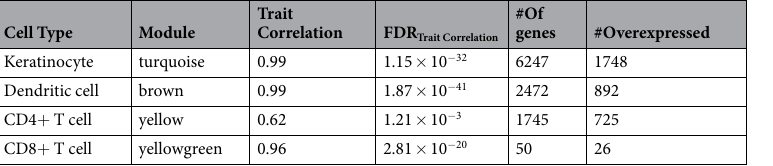
Table 1. Module eigengenes that are significantly correlated with each cell type (FDR ≤